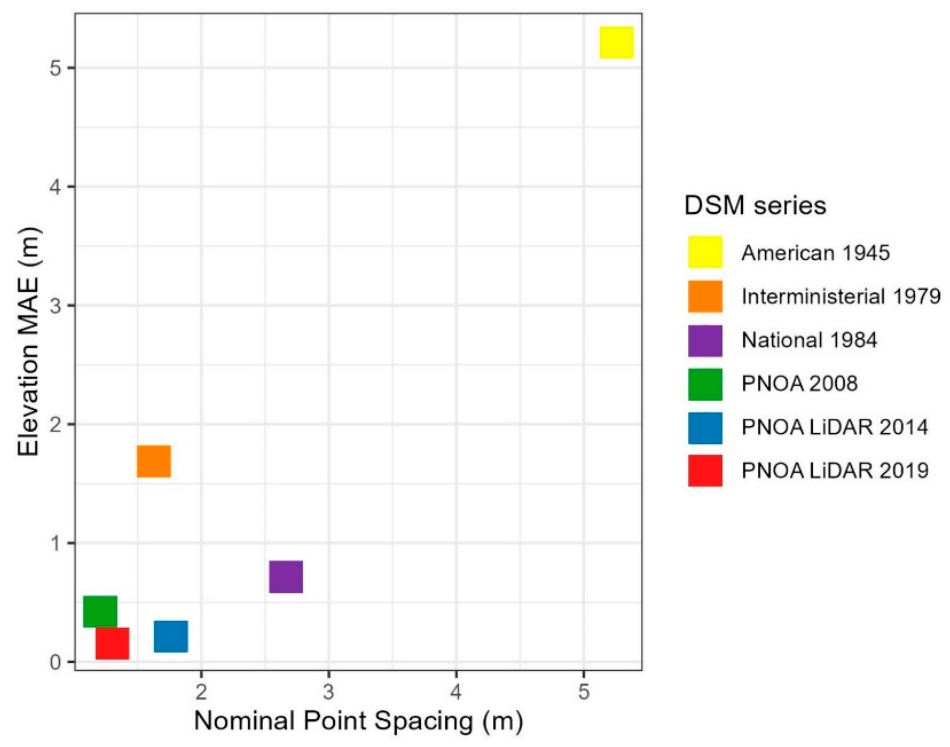
Figure 8. Quality assessment of the DSM series using MAE and density metrics (NPS).